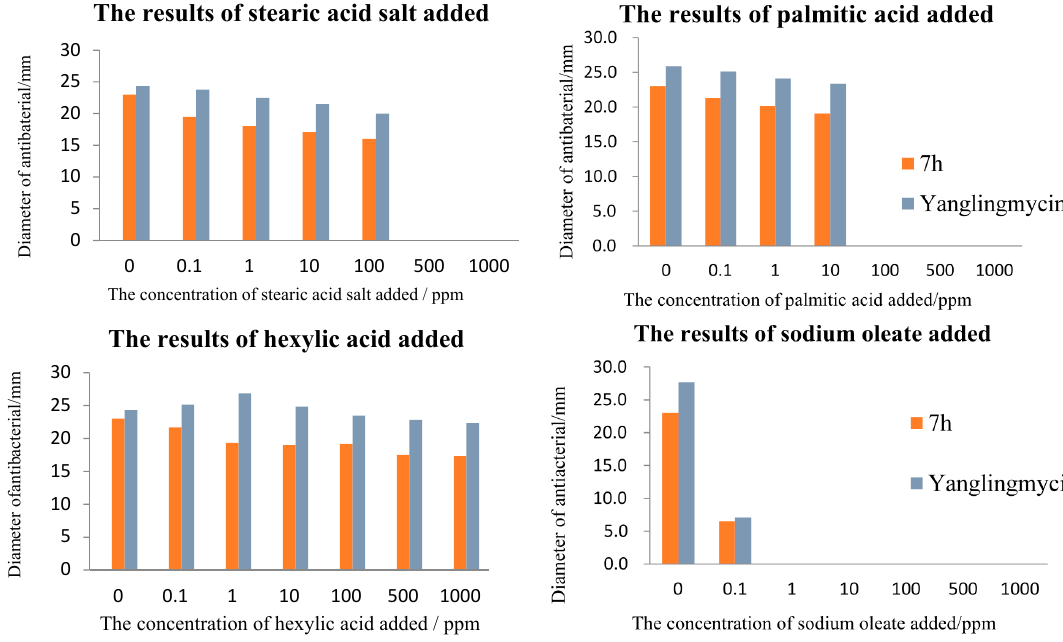
Figure 2. The fatty acid exposure experiments of compound 7h .